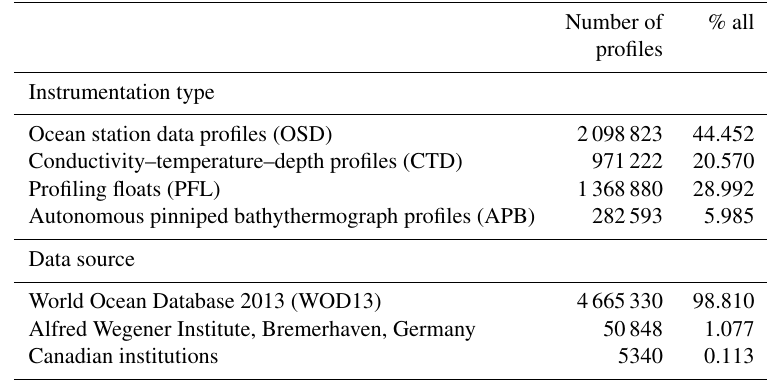
Table 1. Instrumentation types and data sources that contributed to the WAGHC climatology.